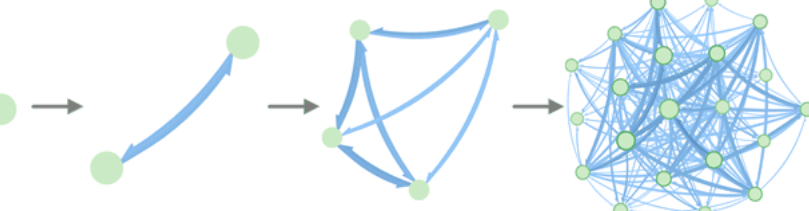
Figure 3. The construction of an urban spatial linkages network. (The thickness of the line segment represents the strength of the connection between urban nodes, the direction of the arrow indicates the direction in which the connection is generated; the size of the node reflects the number of nodes to which the node is linked).